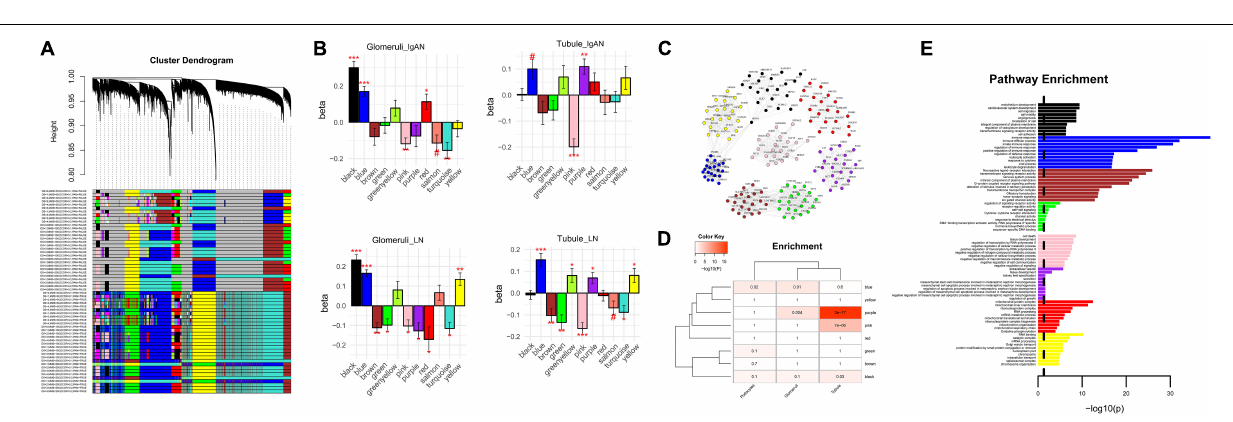
FIGURE 3 | Network analysis of co-expressed genes across the diseases. (A) Network dendrogram of the co-expression topological overlap of genes across IgAN and LN. Colored bars show the correlation of gene expression with disease status and biological and technical covariates. As a result, 13 co-expression modules were constructed and shown in different colors. These modules ranged from large to small according to the number of genes included. (B) Module-level differential expression is perturbed across disease states. Plots show beta values from a linear mixed-effect model of module eigengene association with disease status [false discovery rate (FDR)-corrected # P < 0.1, * P < 0.05, ** P < 0.01, and *** P < 0.001]. (C) The top 20 hub genes are plotted for modules in diseases. See data Supplementary Table 2 for a complete list of module membership (kME) of the genes. Edges are weighted by the strength of the correlation between genes. (D) Cell-specific enrichment based on RNAseq of purified cell populations from healthy human kidney samples. Blue module was enriched for glomerulus and podocyte; both pink module and purple module were enriched for renal tubule. (E) Gene ontology enrichment of the top 10 pathways shown for each module among eight